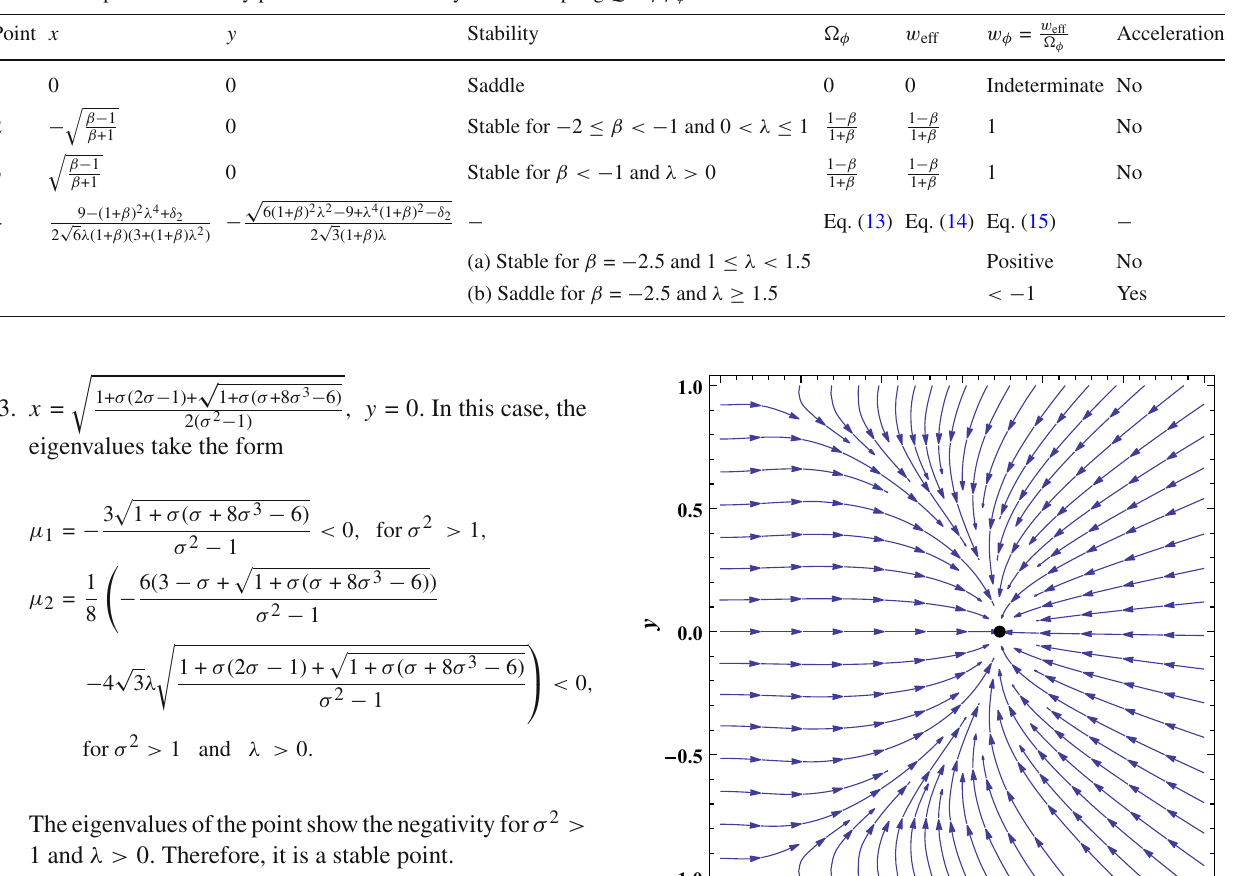
Q = σ ( ˙ ρ m + ˙ ρ φ ),thepoint(3)isstablewithanon-accelerating phase as the equation of state is positive (see Table 3). There- fore, in the interacting phantom field models, the coincidence problem cannot be solved. Similar results were discussed in Ref.